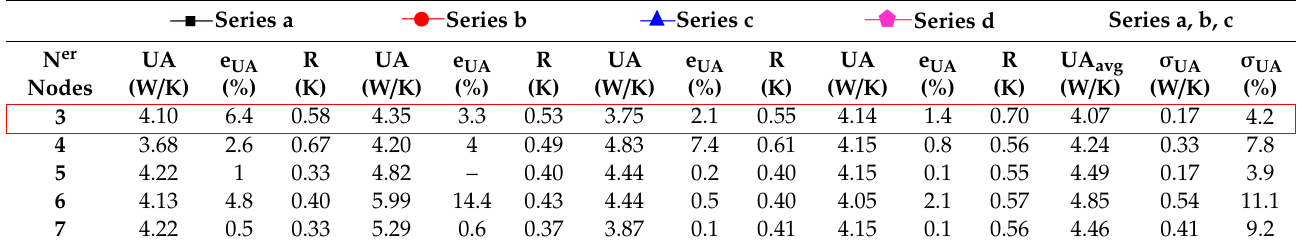
Table 10. Whole building. Summary of results. Output: T i . UA values, and average of the residuals. Where e UA is the error and R is the average of the residuals given by LORD for each data series.